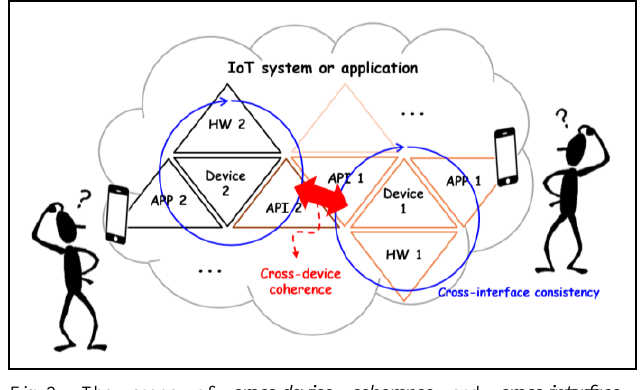
Fig. 2. The scope of cross-device coherence and cross-interface consistency